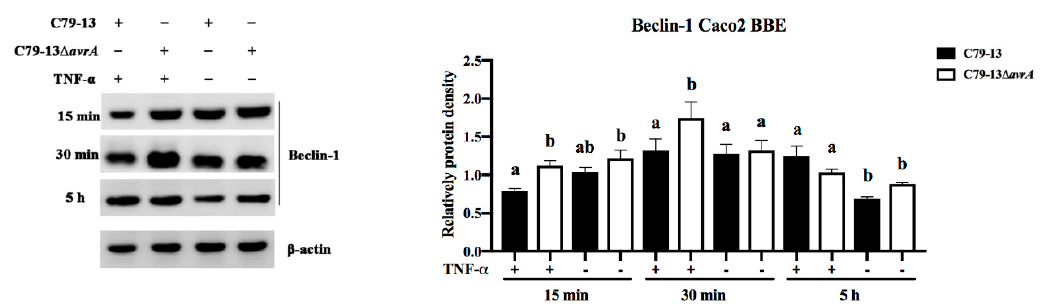
Figure 4. SP-AvrA inhibited Beclin-1 expression in S. Pullorum-infected Caco2 BBE cells induced by TNF- α . Caco2 BBE cells were infected with S. Pullorum C79-13 and C79-13 ∆ avrA . After 1 h incubation, the cells were treated with TNF- α (15 ng/mL) for 15 min, 30 min, or 5 h and subjected to Western blot analysis of Beclin-1. Protein band density was analyzed by using the NIH ImageJ software. Data are representative of three independent experiments. Data are expressed as the mean + SD. The different letters on the error bars indicate statistically significant differences ( p < 0.05).